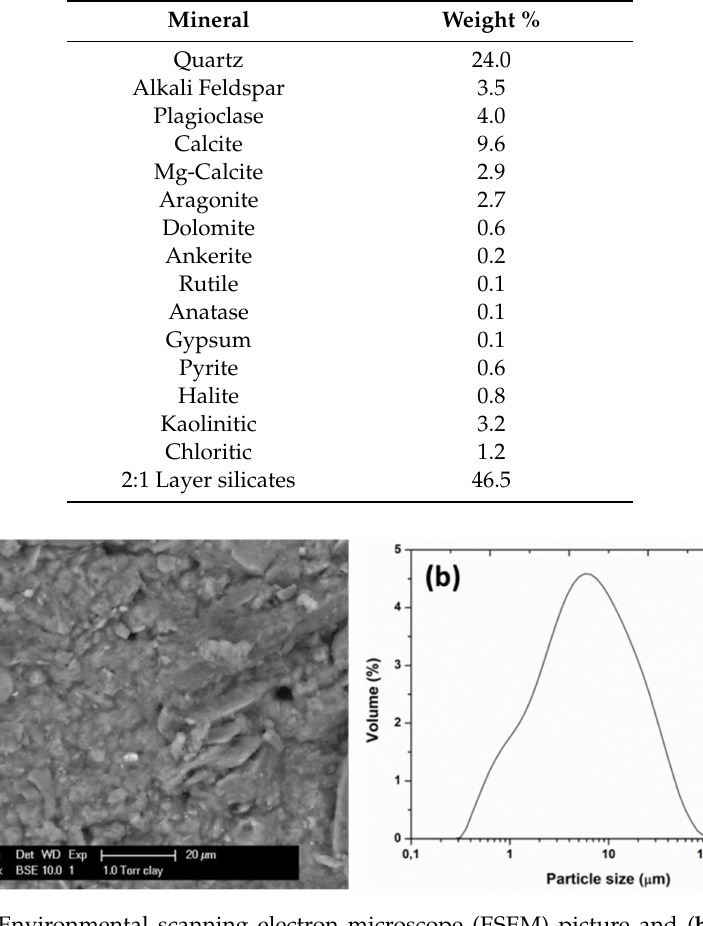
Figure 1. ( a ) Environmental scanning electron microscope (ESEM) picture and ( b ) particle size distribution of the clay.